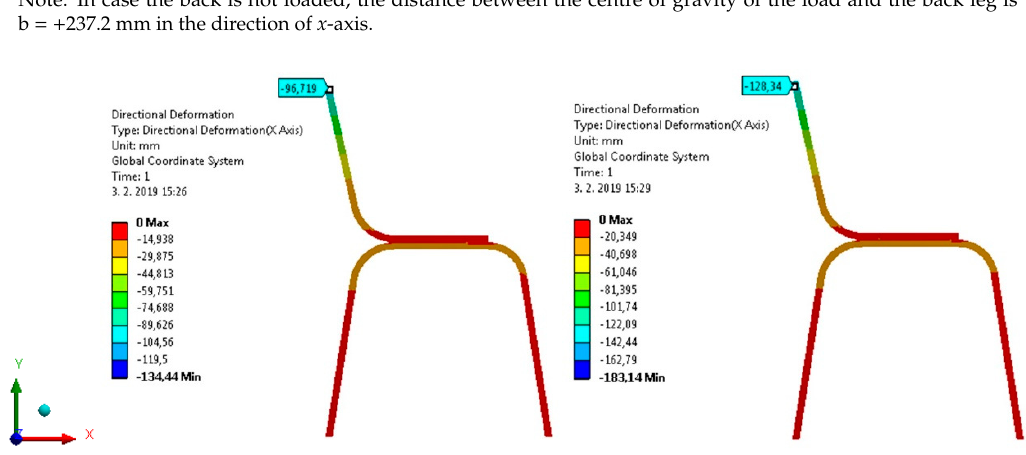
Figure 7. FEM visual outputs of deformation and displacement of the back while the load is applied. Left figure for 110 kg and right figure for 150 kg.